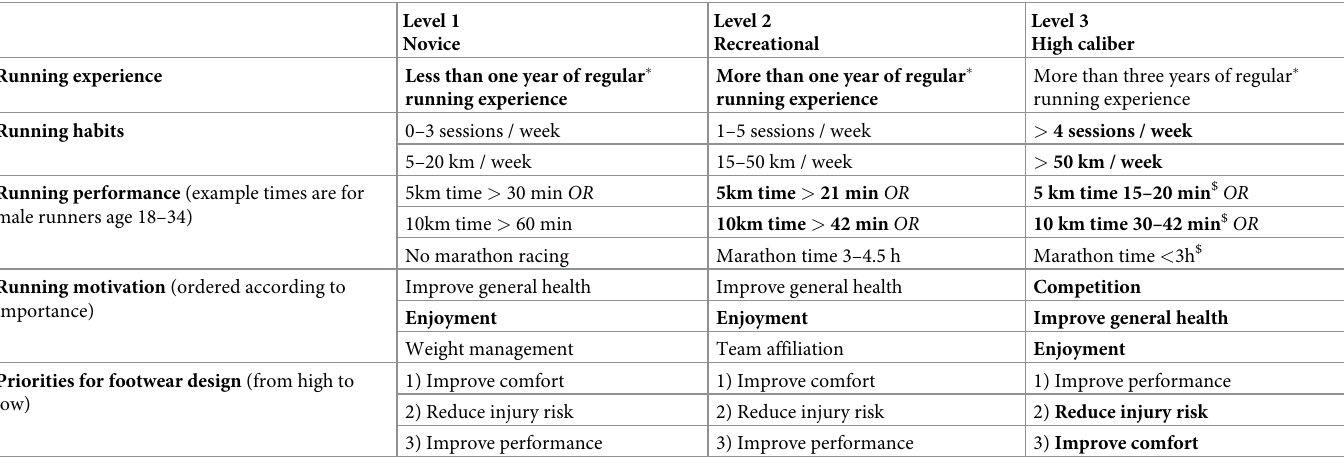
Table 3. Final running level